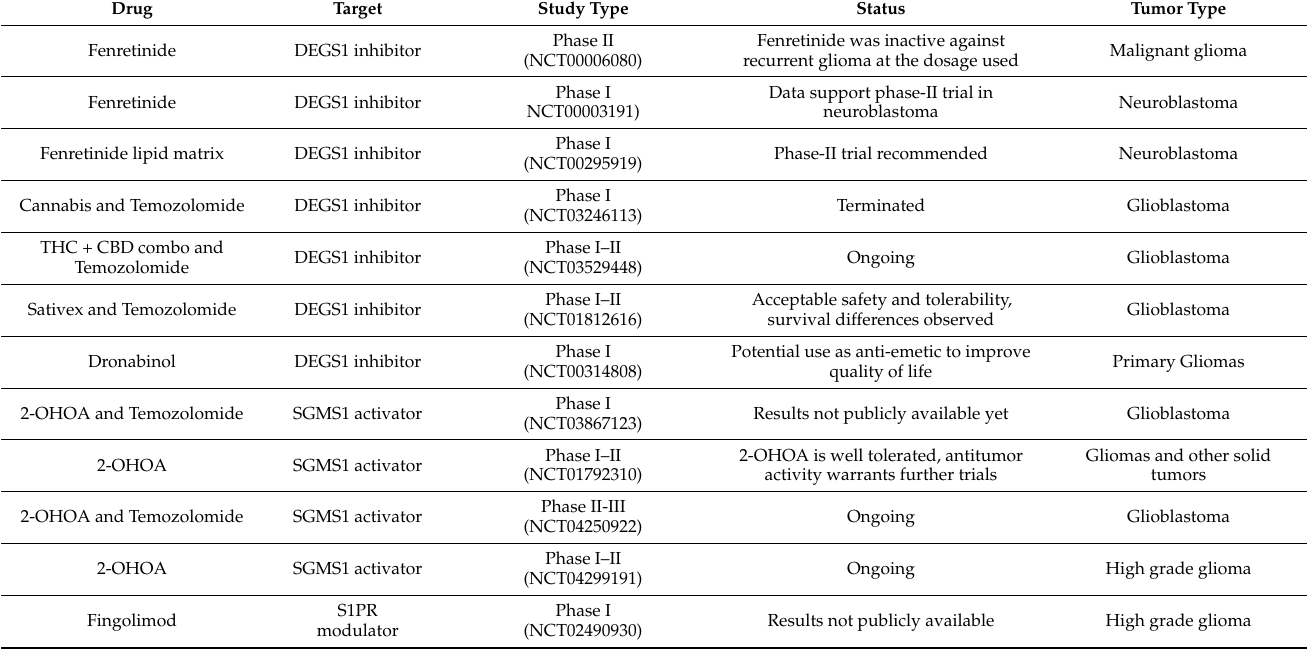
Table 1. Clinical trials on sphingolipid modulators in brain